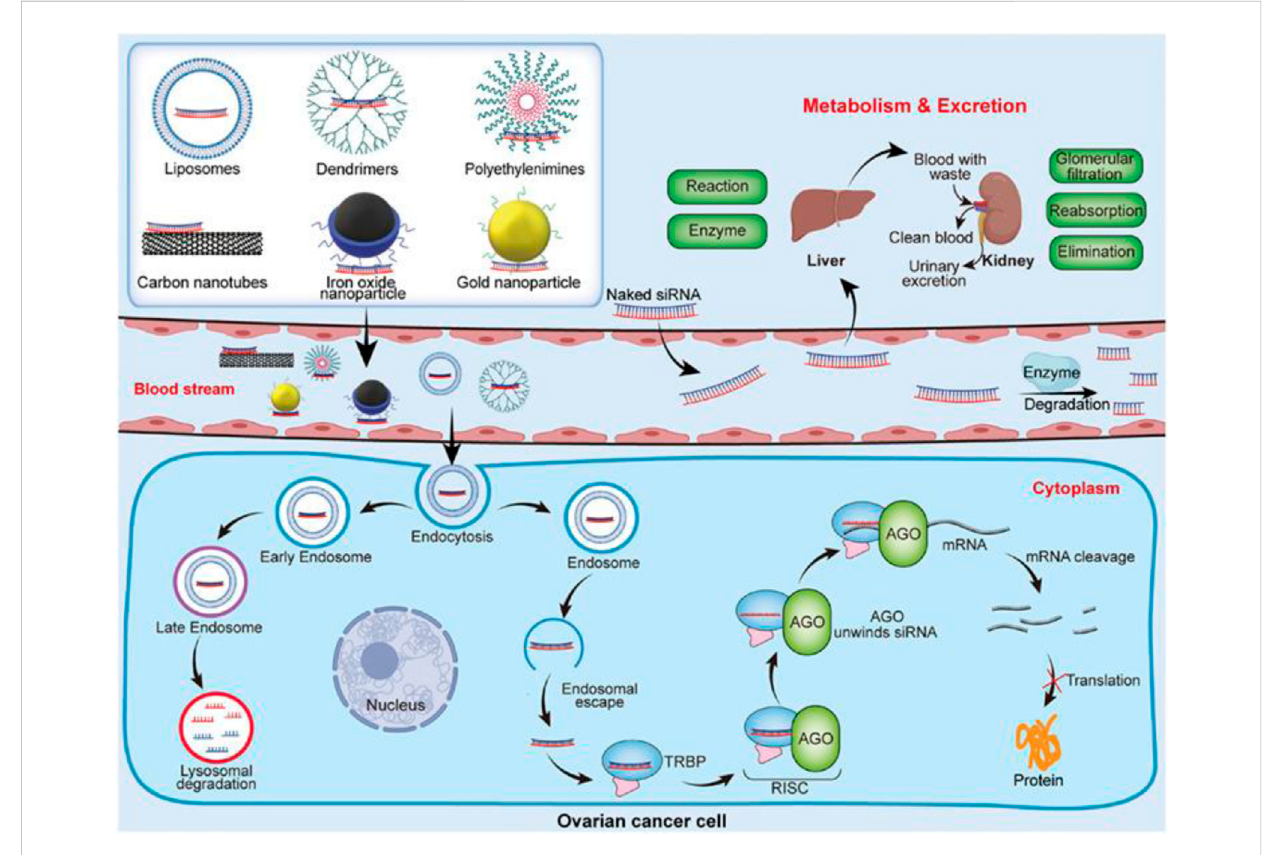
FIGURE 2 Nanocarrier-mediated siRNA delivery and its mechanism of action. Reproduced with permission from reference (Zou et al.,